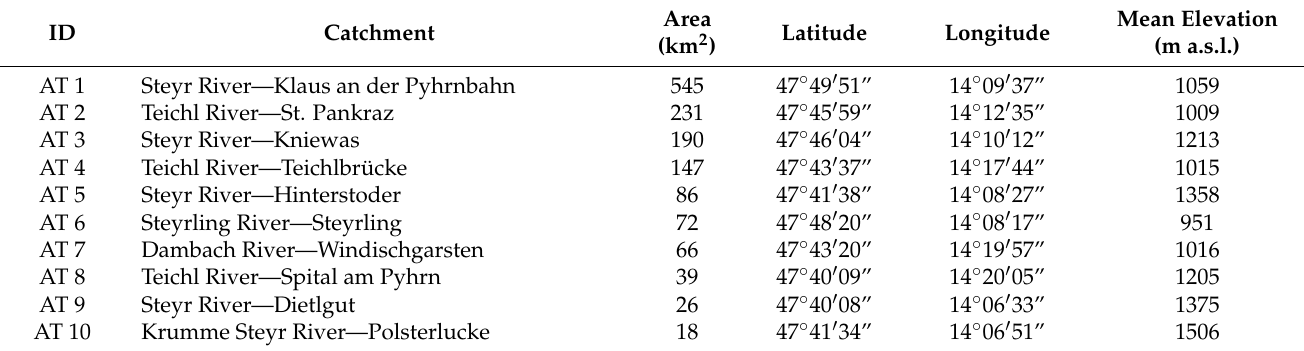
Table 2. Characteristics of catchments and geographical coordinates of the catchment outlets in the Steyr River basin